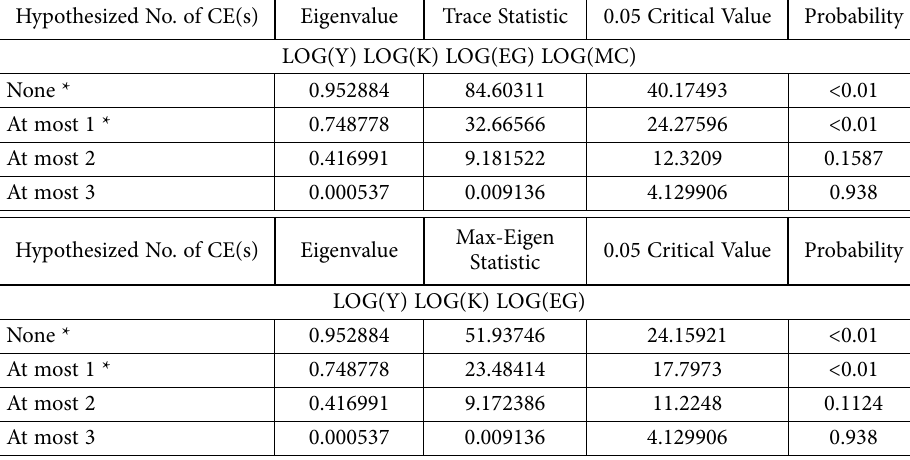
Table 8. Johansen cointegration test (source: authors’ processing based on WBD, Eurostat, ILO and NIS data) Hypothesized No. of CE(s) Eigenvalue Trace Statistic